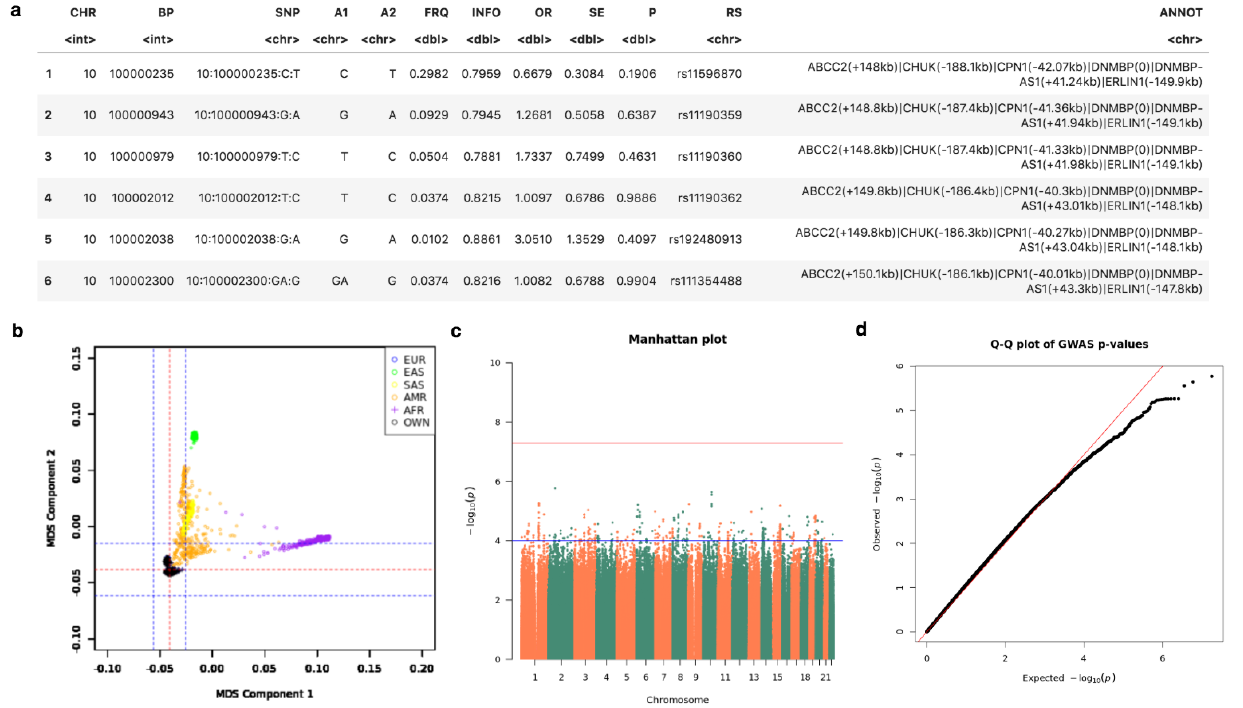
Figure 8. Tabular and graphical outputs from GWAS. ( a ) top annotated SNPs. ( b ) Multidimensional Scaling plot for population stratification. ( c,d ) Manhattan and QQ